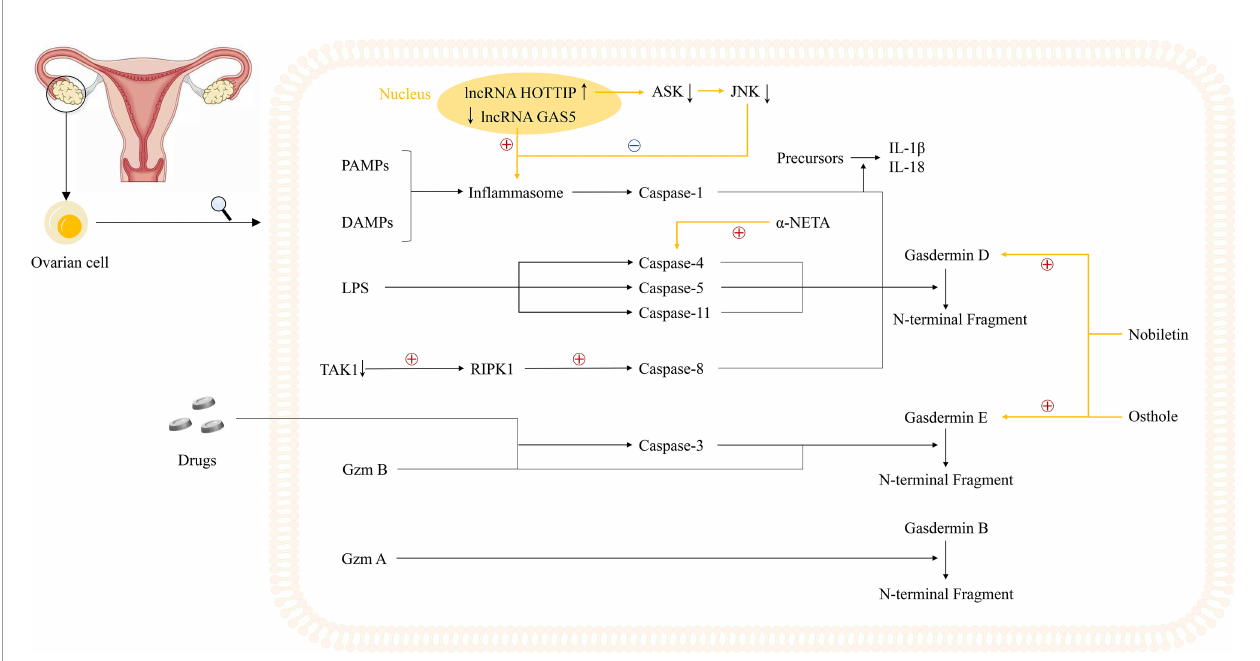
FIGURE 2 | Potential mechanisms underlying pyroptosis in ovarian cancer cells and current study foundations. Notably, two lncRNAs, GAS5 and HOTTIP, play an important role in the regulation of in fl ammasomes. The inhibited expression of lncRNA GAS5 in ovarian cancer could trigger the formation of in fl ammasome while lncRNA HOTTIP is highly expressed in ovarian cancer, the knockdown of which leads to upregulation of ASK1/JNK signaling, elevated formation of NLRP1- in fl ammasome, and pyroptosis. Moreover, three novel small molecules including osthole, nobiletin, and a -NETA are reported to regulate the pyroptosis process in ovarian cancer cells. Osthole and nobiletin are of high similarity since they both have an effect on ROS production, MMP, and LC3-related autophagy. However, osthole could mediate GSDME-dependent pyroptosis while nobiletin could mediate pyroptosis through GSDMD- and GSDME-dependent ways. Moreover, a -NETA treatment causes epithelial ovarian cancer cell death through pyroptosis, with dramatically augmented level of GSDMD and